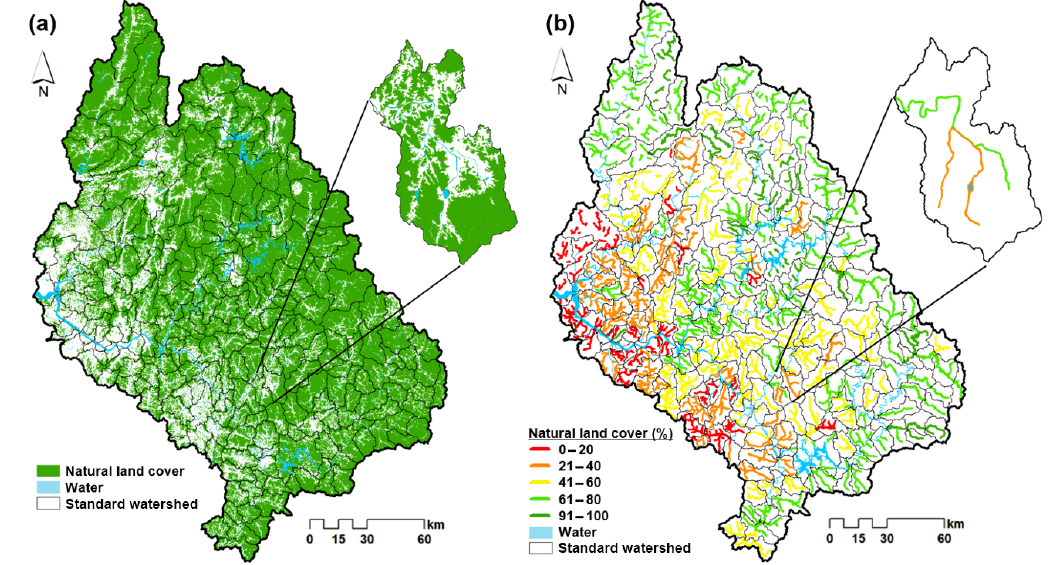
Figure 3. Landscape condition for the (a) green area and (b) riparian